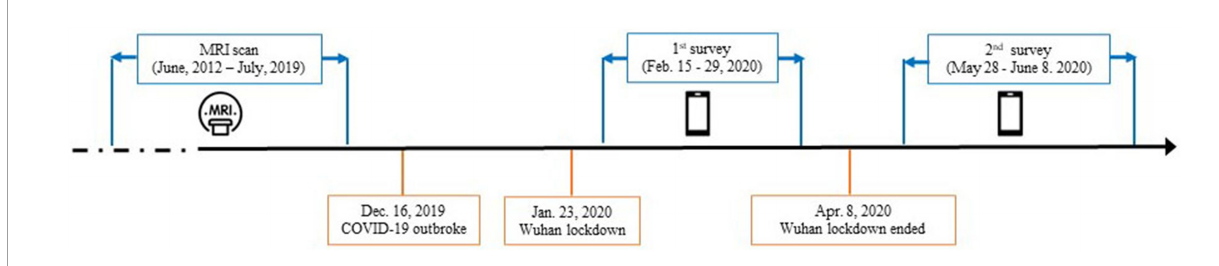
FIGURE1 Timeline of data collection with the dates of major events relevant to the COVID-19 pandemic.